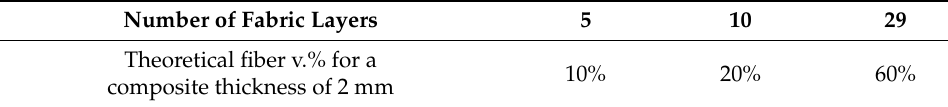
Table 1. Theoretical fiber v.% for selection of the number of textile layers.